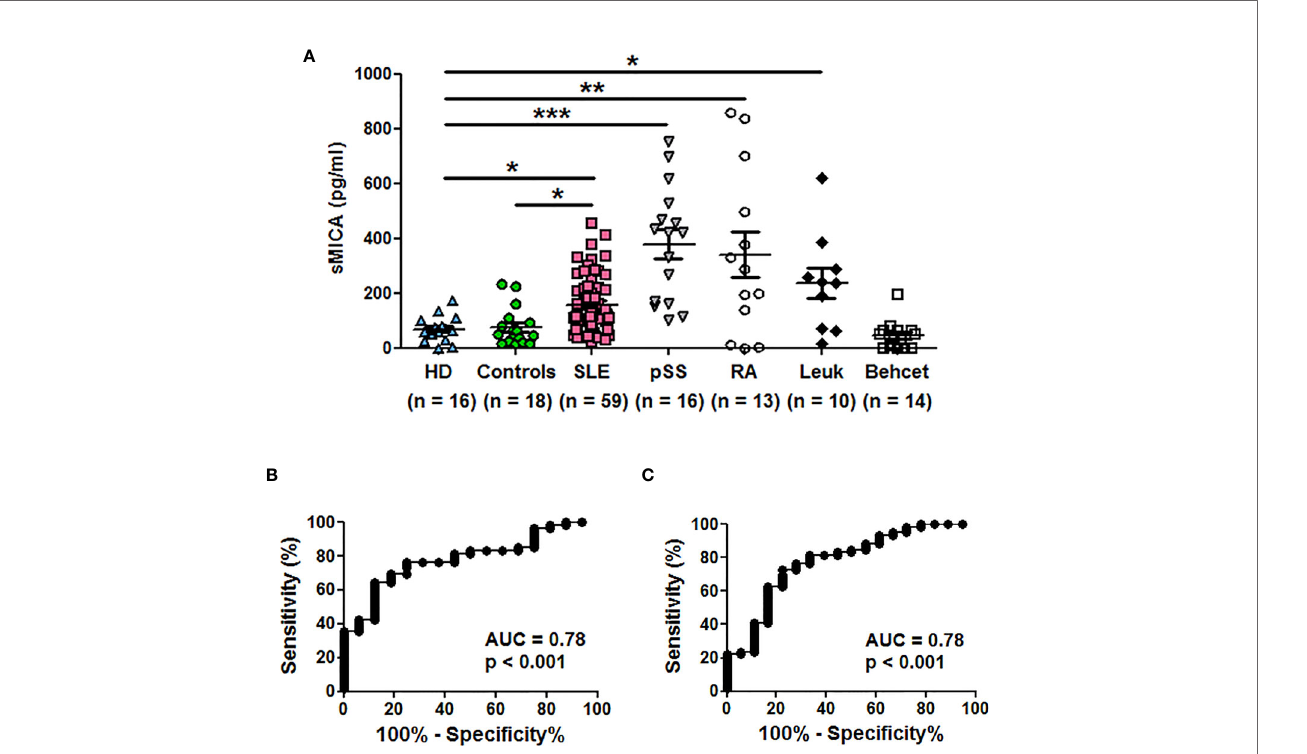
FIGURE 1 | Soluble MICA concentrations are increased in sera of SLE patients and primary Sjögren ’ s syndrome patients in comparison to healthy individuals or control patients. (A) Serum concentrations of sMICA have been determined by ELISA. Each dot represents an independent donor. HD, healthy donors; Controls, patients not treated by immunosuppressive drugs and suffering from fi bromyalgia, uveitis, Raynaud ’ s syndrome, chronic fatigue syndrome, tinnitus or inner ear hearing impairment; SLE, systemic lupus erythematosus; pSS, primary Sjögren ’ s syndrome; RA, rheumatoid arthritis; Leuk, leukemia. Mean and SEM of all donors are shown. *p < 0.05; **p < 0.01; ***p < 0.001 (Kruskal-Wallis test with Dunn ’ s multiple comparison test). Data were also signi fi cant when compared to the control patient group but signi fi cance is not depicted for clarity. (B) ROC curve illustrating the power of sMICA for discrimination between SLE patients and healthy individuals. AUC, area under the curve. (C) ROC curve illustrating the power of sMICA for discrimination between SLE patients and the control patient group.